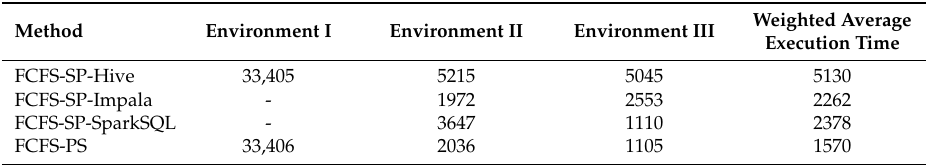
Table 13. Performance comparison among the methods for Case 2 (unit: s).